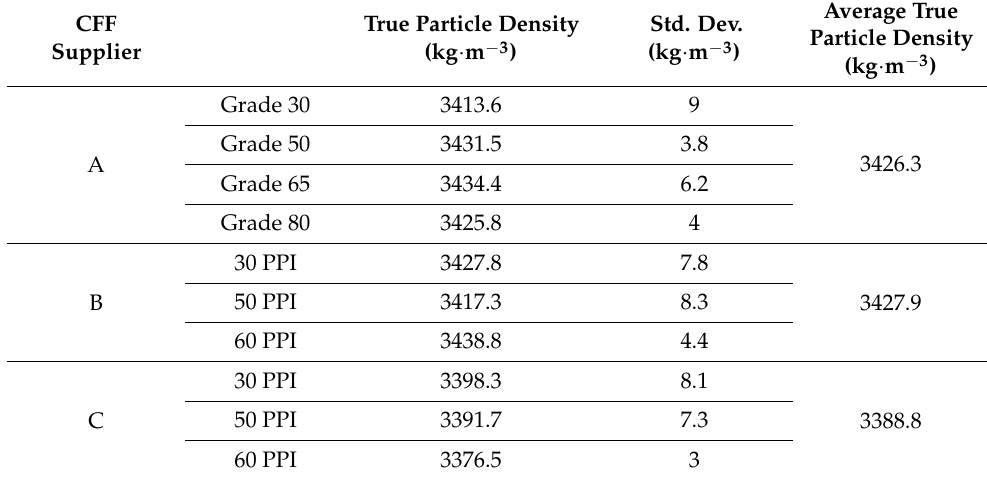
Table 2. The true particle density of CFFs from suppliers A, B, and C.